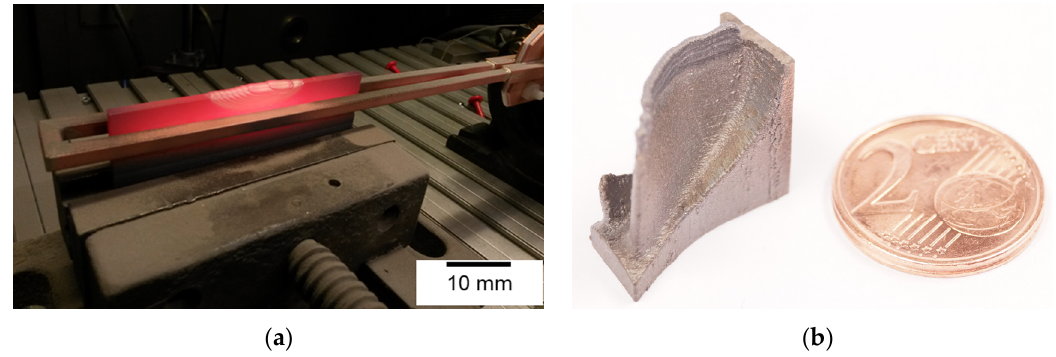
Figure 3. Photographs of hybrid γ -TiAl samples. ( a ) DED and cast, ( b ) DED and LPBF.